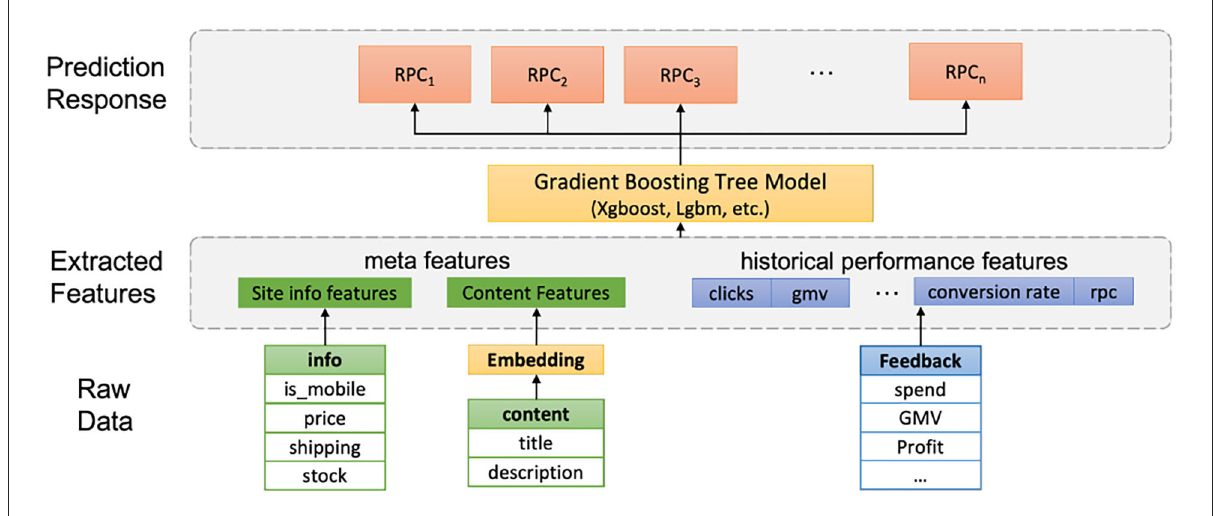
FIGURE4 Model training: Gradient boosting regression